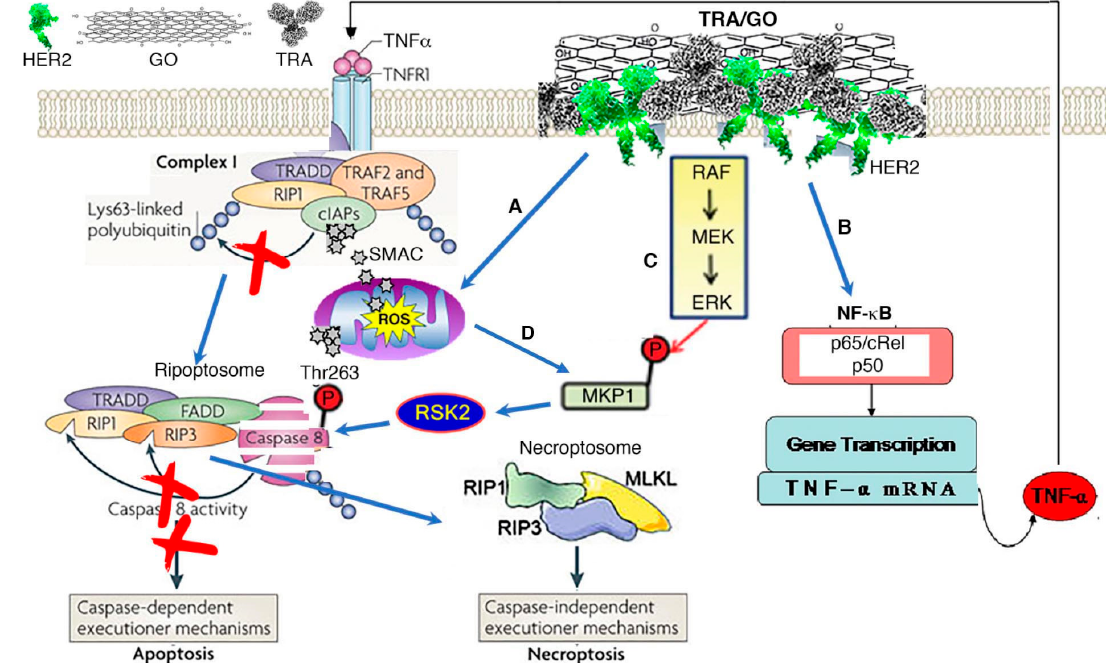
Figure 2. Mechanism of TRA/GO action. ( A ) TRA/GO induces ROS production. ROS disrupts mitochondrial integrity, releasing SMAC/DIBLO into cytosol. Binding of SAMC to cIAPs prevent RIP1 ubiquitylation, allowing formation of death complex ripoptosome. ( B ) Binding of TRA/GO to HER2 causes HER2 homodimerization, eliciting HER2 signaling; this activates NF-kB through the canonic pathway, augmenting TNF α production. TNF α singling through TNFR1 promotes degradation of cIAPs. ( C ) HER2 signaling also activates MAPK pathway, resulting in activation RSK2 that phosphorylate caspase 8 at Thr263 site to induce caspase ubiquitination and proteosomal degradation. Degradation of caspase 8 leads to formation of necroptosome executing necroptosis. ( D ) ROS also contributes to MAPK activation.